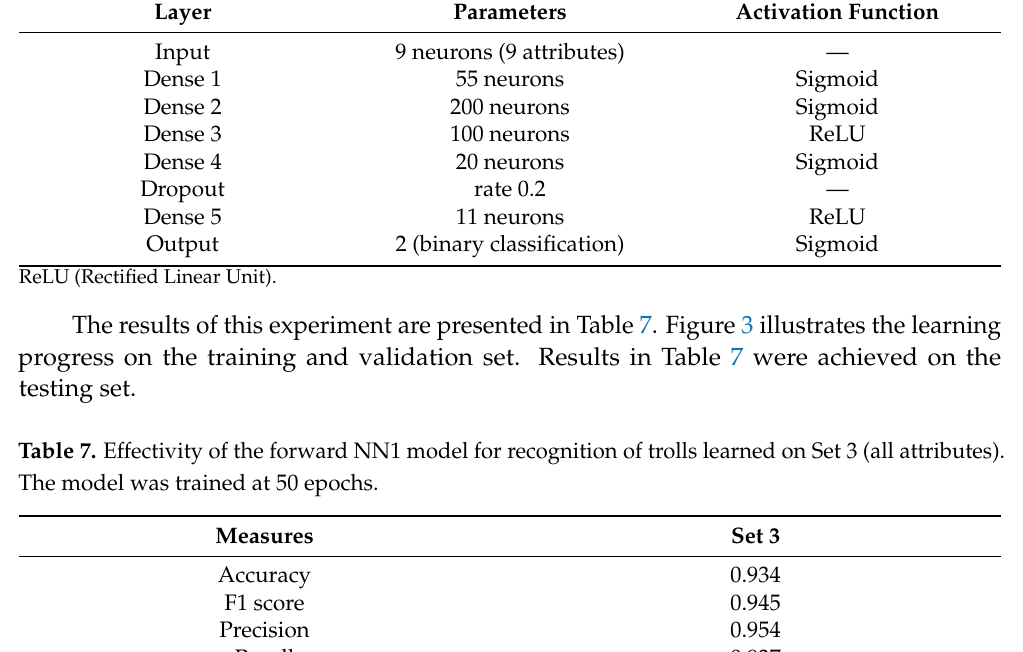
Table 6. Architecture of NN1 model in the first experiment (Adam optimization, 50 epochs). Layer Parameters Input — Dense 1 55 neurons Dense 2 200 neurons Dense 3 100 neurons ReLU Dense 4 20 neurons rate 0.2